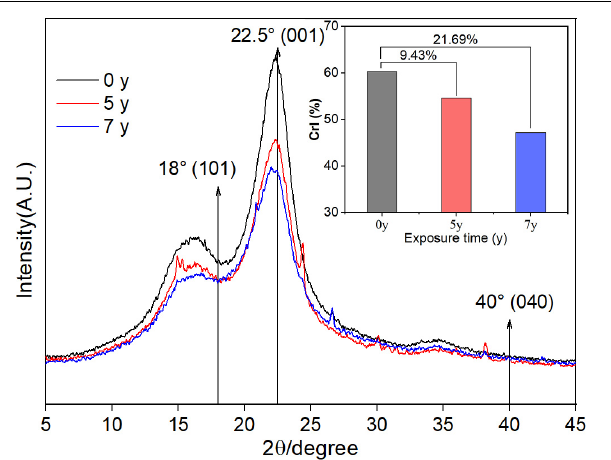
FIGURE 5 | Fourier transform infrared spectroscopy (FTIR) spectra of the Salix psammophila Sand Barrier.